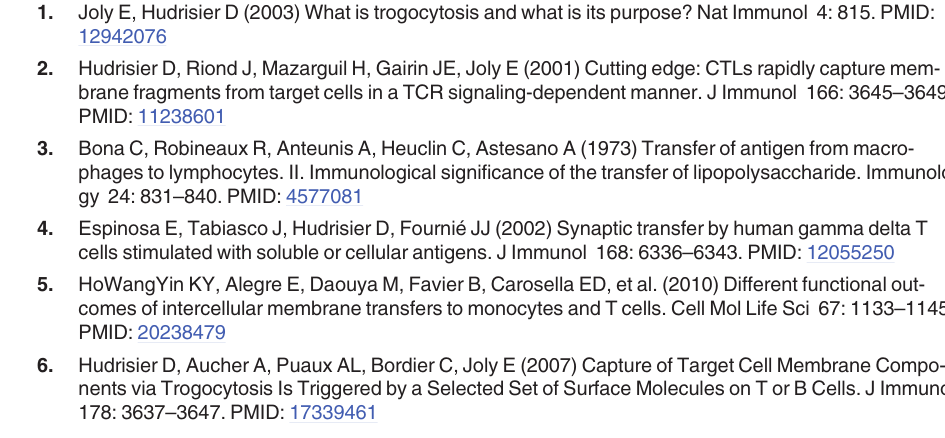
S1 Fig. Non melanoma-reactive CTLs do not activate a MART-1-reactive clone. MUC-1 specific CD8 + T cells were co-cultured with 624 mel , sorted using positive selection with 71- magnetic particles and evaluated as CD8 + T-APC for MART-1-specific 2E2 lymphocytes, pre- labeled with surface biotin. Following co-culture for 1 hour at 37°C, cytolytic activity of effector CTLs was measured by detection of surface CD107A on streptavidin-APC-positive 2E2 cells. (TIF) S2 Fig. Degranulation of CTLs upon non-specific activation or co-culture with activated CTL. (A) 2E2 T cells were activated by PMA/ionomycin or plate-bound anti-CD3/CD28 anti- bodies. Following activation, CTLs were double-stained with anti-CD8 and anti-CD107A anti- bodies and analyzed by flow cytometry. Grey histogram , background staining with isotype control mAb; Black histogram , staining with anti-CD107A mAb gated on CD8 + cells. (B) 2E2 T cells were activated by PMA/ionomycin or anti-CD3/CD28 antibodies and examined as CD8 + T-APC for biotin-labeled resting 2E2 cells, used as effector CTL. Following 1 hour co-cul- ture, the cells were stained with anti-CD107A mAb and streptavidin and analyzed by flow cy- tometry. The cytolytic activity of effector CTL was measured by detection of CD107A on the streptavidin + population. Grey histogram , CD107A staining of effector CTL only; Black histo- gram , CD107A staining of effector CTL co-cultured with activated CD8 + T cells. (TIF) S1 Movie. Visualization of cell-cell interactions between lymphocytes. 2E2 cells used as CD8 + T-APC or as effector CTL were pre-labeled with the lipophilic dyes PKH67 and PKH26 respectively, and co-incubated in a chambered cover glass for 1 hour at 37°C.